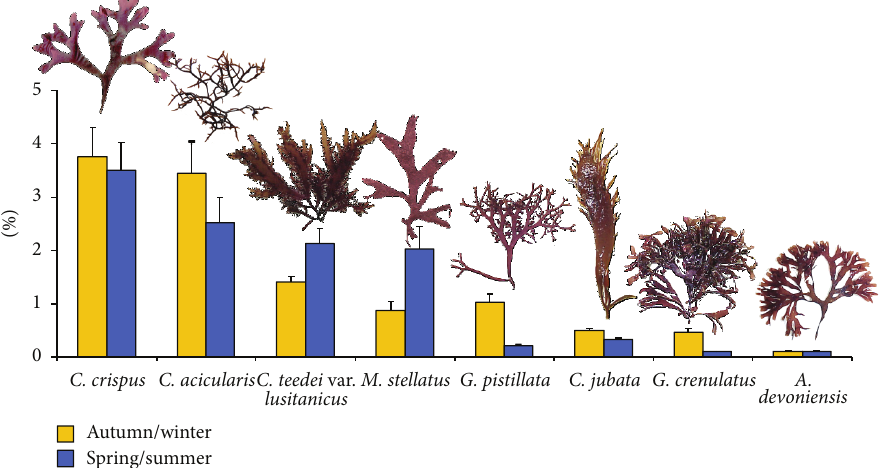
Figure 2: Carrageenophytes coverage in autumn/winter and spring/summer (average ± standard error, 𝑛 = 46